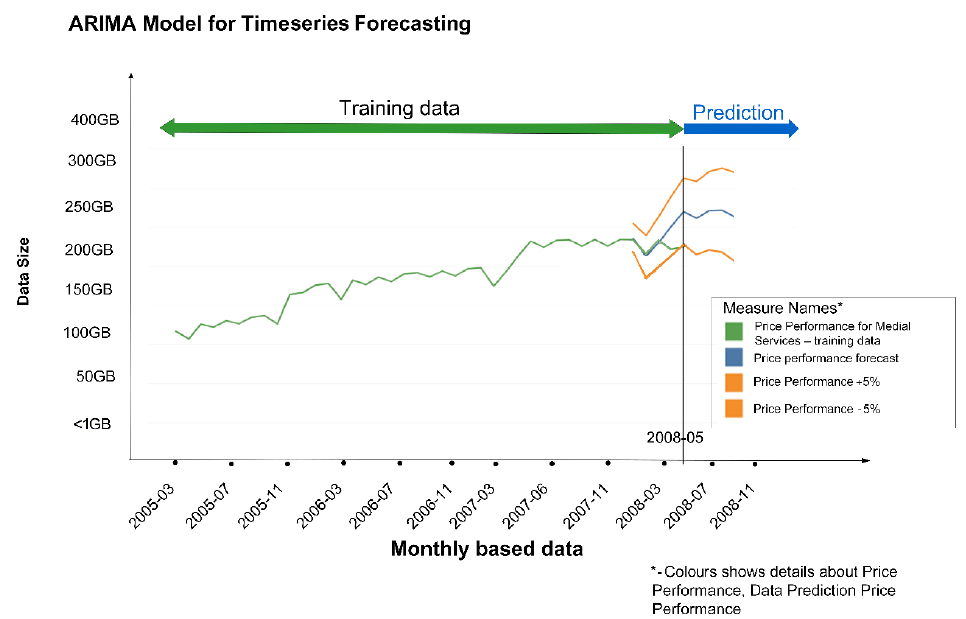
Figure 4. Example of predictive model for time series forecasting based on supplied test data from IHIS. The example demonstrates part of a data processing and visualisation layer (Figure 2) shown as a screenshot produced in Tableau Desktop (version 10.5).